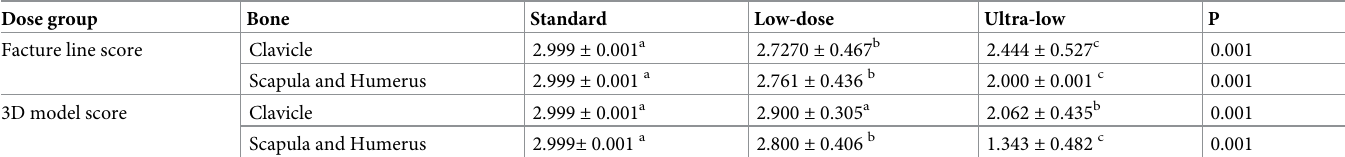
Table 3. Subjective evaluation of the different groups. Dose